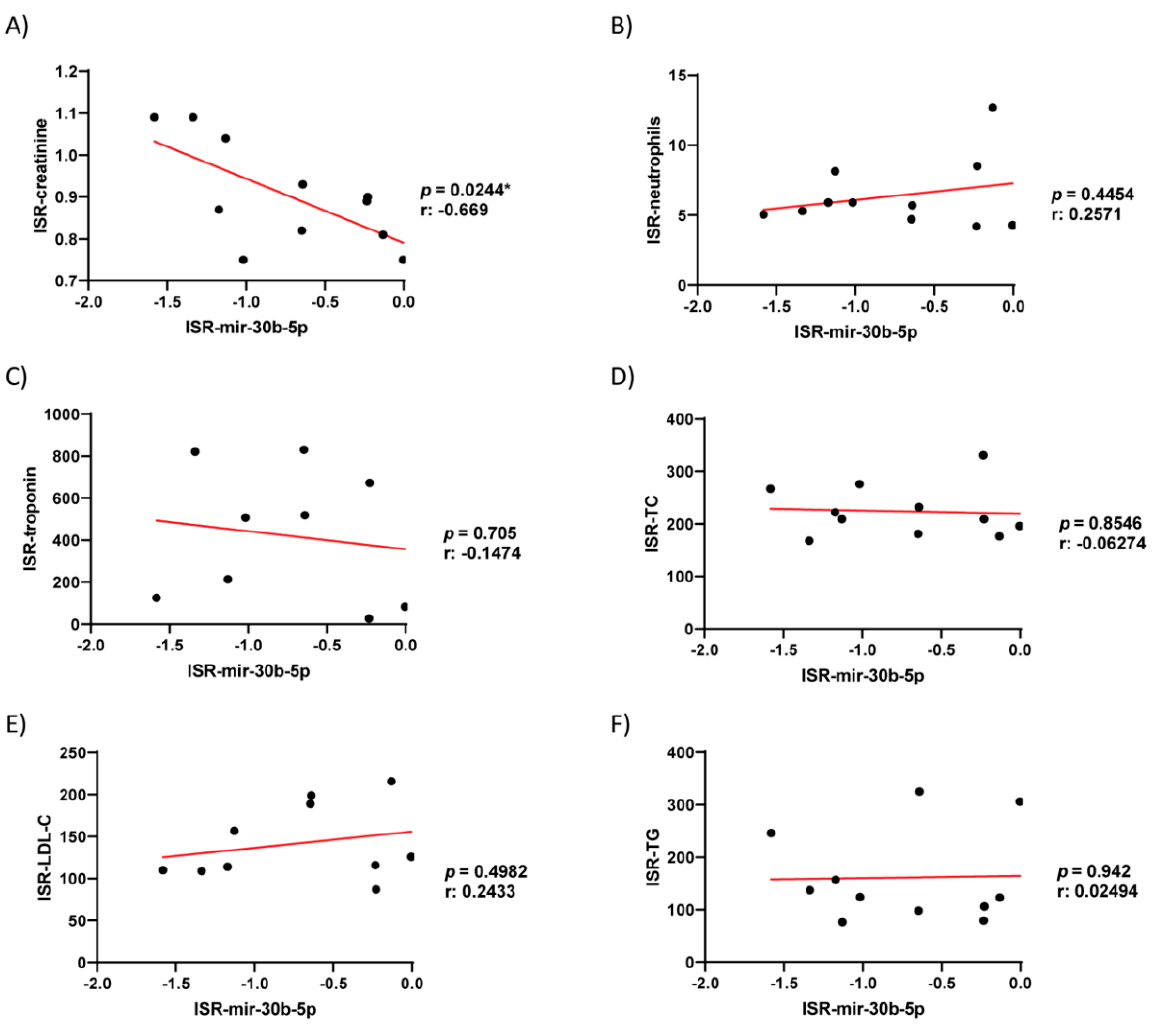
Figure 6. ROC analysis from hemodynamic parameters in patients’ group. ( A – F ) Graphs illustrate area under the curve (AUC) analysis of ROC indicating sensitivity and specificity of creatinine ( A ), neutrophils ( B ), troponin ( C ) , total choles- terol (TC; D ), Low-Density Lipoprotein cholesterol (LDL-C; E ), Triglyceride (TG; F ). Values are given on the graphs. Rose color indicates ISR patients.